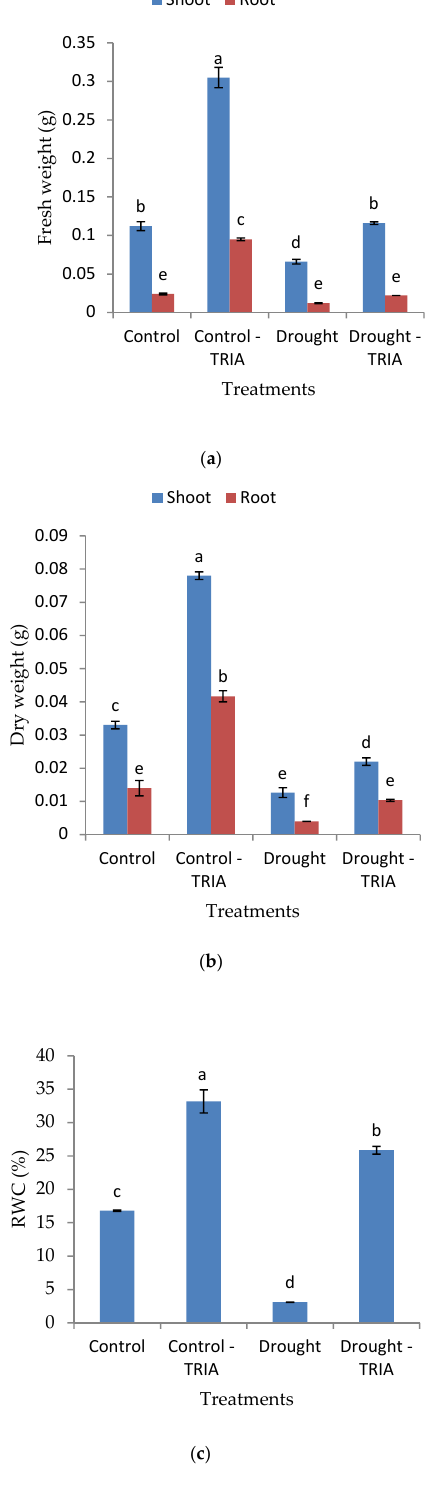
Figure 1. Effect of TRIA (35 ppm) treatment on ( a ) fresh weight, ( b ) dry weight, and ( c ) relative water content of drought-stressed rice seedlings. Each value is the mean of three replicates ± SE. Columns with different letters are significantly different at p ≤ 0.05.